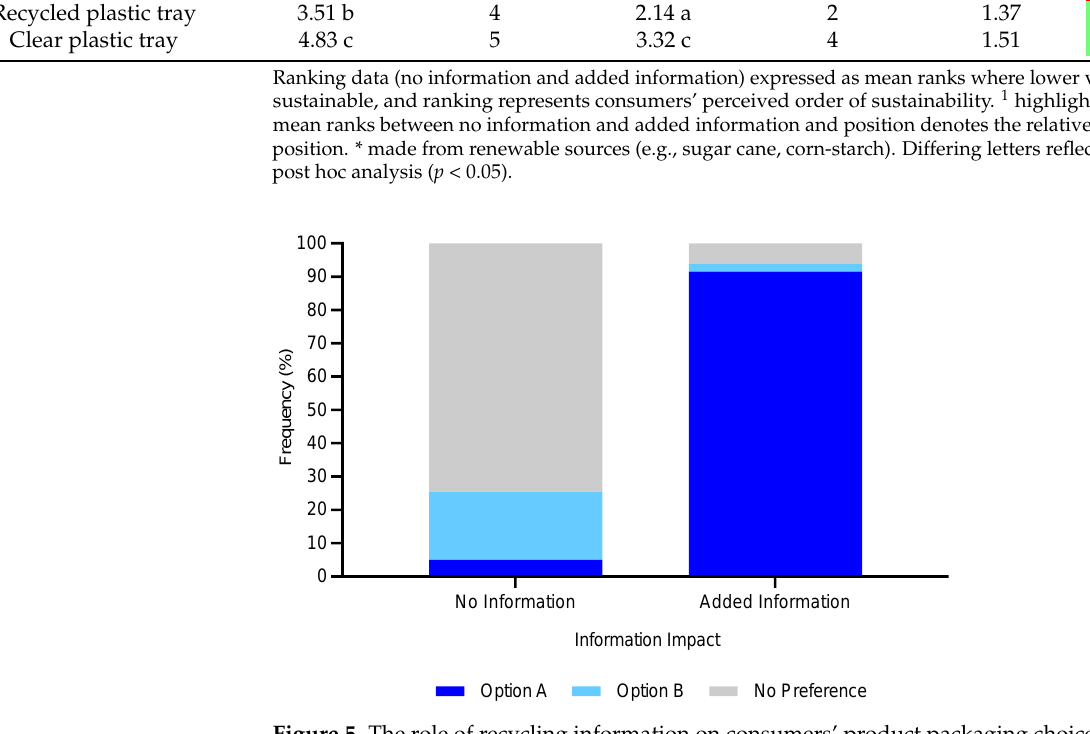
Figure 5. The role of recycling information on consumers’ product packaging choice ( n = 405) from a three-point category scale.